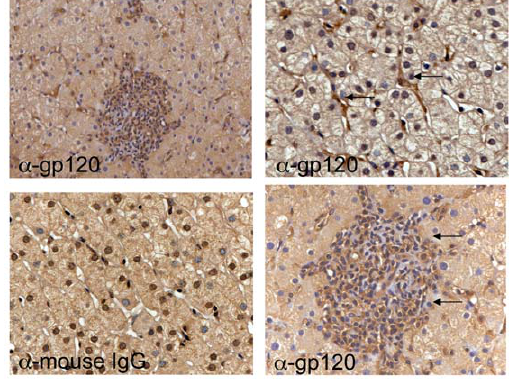
Figure 5. Gp120 is present in liver tissue from HIV/HCV infected patients. Paraffin-embedded liver biopsies from HIV/HCV coinfected patients prior to initiation of ART were immunostained with monoclonal anti-gp120 or isotype control. Sinusoidal staining was appreciated in all 3 specimens. Representative images shown (Magni- fication 100 6 , 630 6 ). Viral load ranges: HIV RNA levels ranged from 514–2,455 copies/ml; HCV RNA levels ranged from 1.2 million–1.6 million